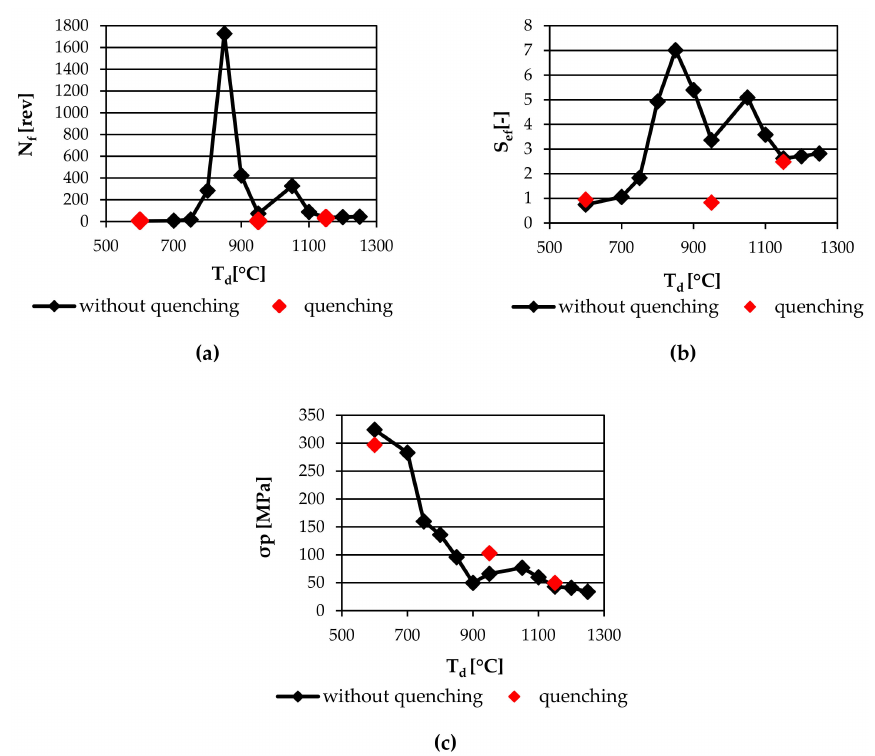
Figure 1. ( a ) Dependence of number of turns to failure (N f ) on test temperature (T d ); ( b ) Dependence of limited deformation intensity (S ef ) on test temperature (T d ); ( c ) Dependence stress ( σ p ) on test temperature (T d